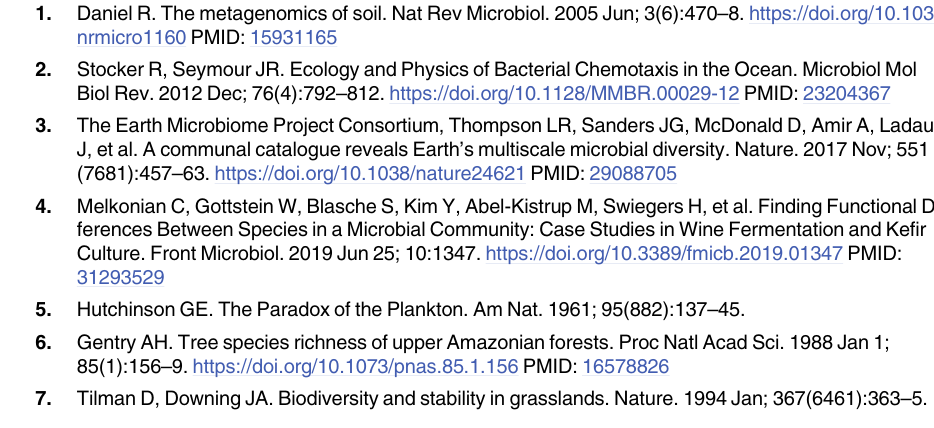
dances are stable in a structured environment–a single matrix element (arrow from C to A ) breaks the ATA competition condition that all values of P > 0. The schematic (bottom) ik shows an arrangement of the three species that is stable in a structured environment, even though an interspecies boundary between A and C is not stable in any structured environment; this is the only arrangement that can stably support all three species for the graph shown. dances of all species, regardless of the interaction between species A and C (no connection shown). (bottom) The schematic shows three possible arrangements of the four species that could allow A and C to coexist regardless of their interaction. These schematics assume that the competition boundaries (black lines) are stable for some set of interaction and structural